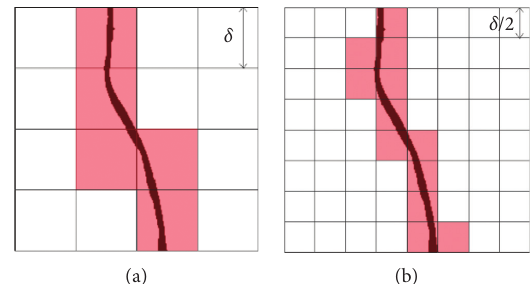
Figure 5: Box-counting dimension calculation. (a) The side of the box is δ . (b) The side of the box is δ